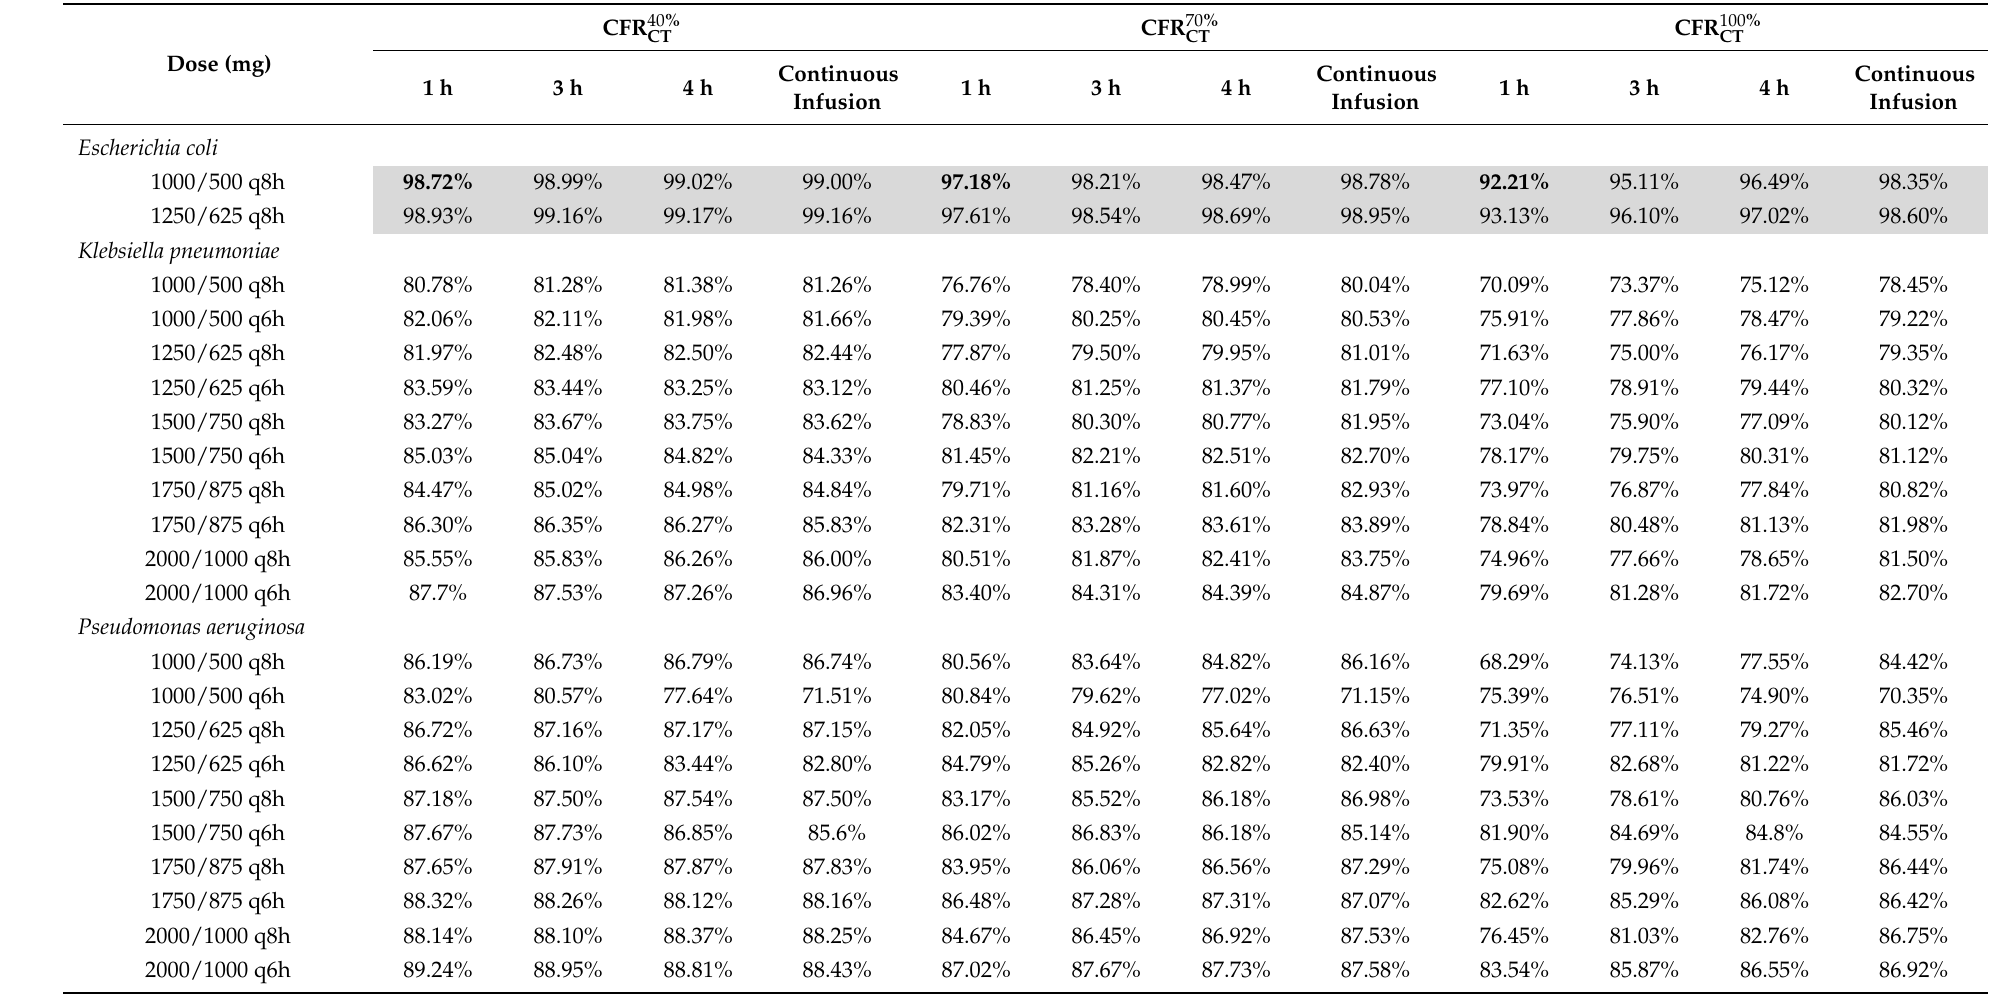
Table 2. Cumulative fraction of responses for ceftolozane/tazobactam for Enterobacteriaceae and Pseudomonas aeruginosa